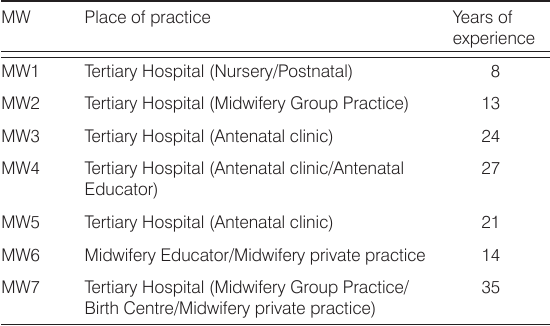
Table 1. Characteristics of midwives who participated in the interview.